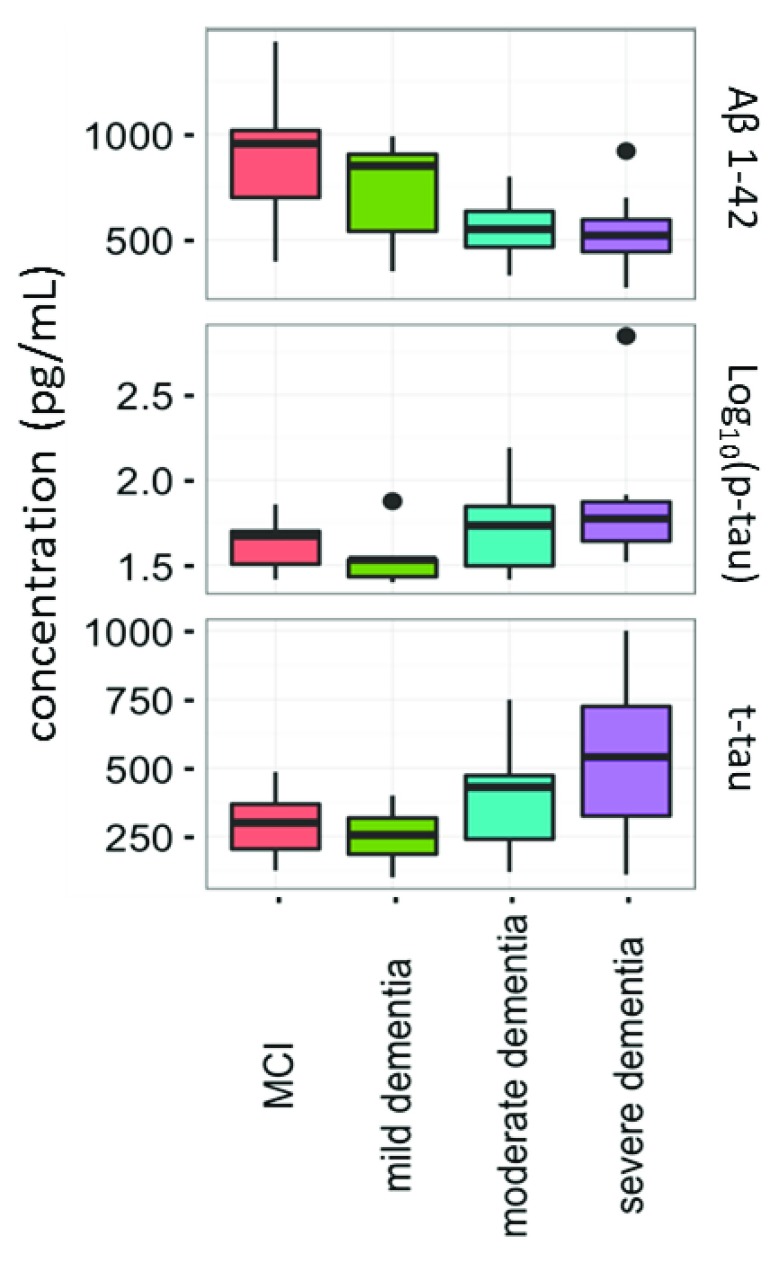
Distribution of core cerebrospinal fluid biomarkers Aβ1-42, t-tau and p-tau.The concentrations of these proteins were compared between mild cognitive impairment (MCI) (n=10) mild (n=7), moderate (n=23) and severe Alzheimer’s disease (n=14). Aβ1-42 and t-tau were significantly different between the tested groups (p<0.05). Horizontal lines represent medians.